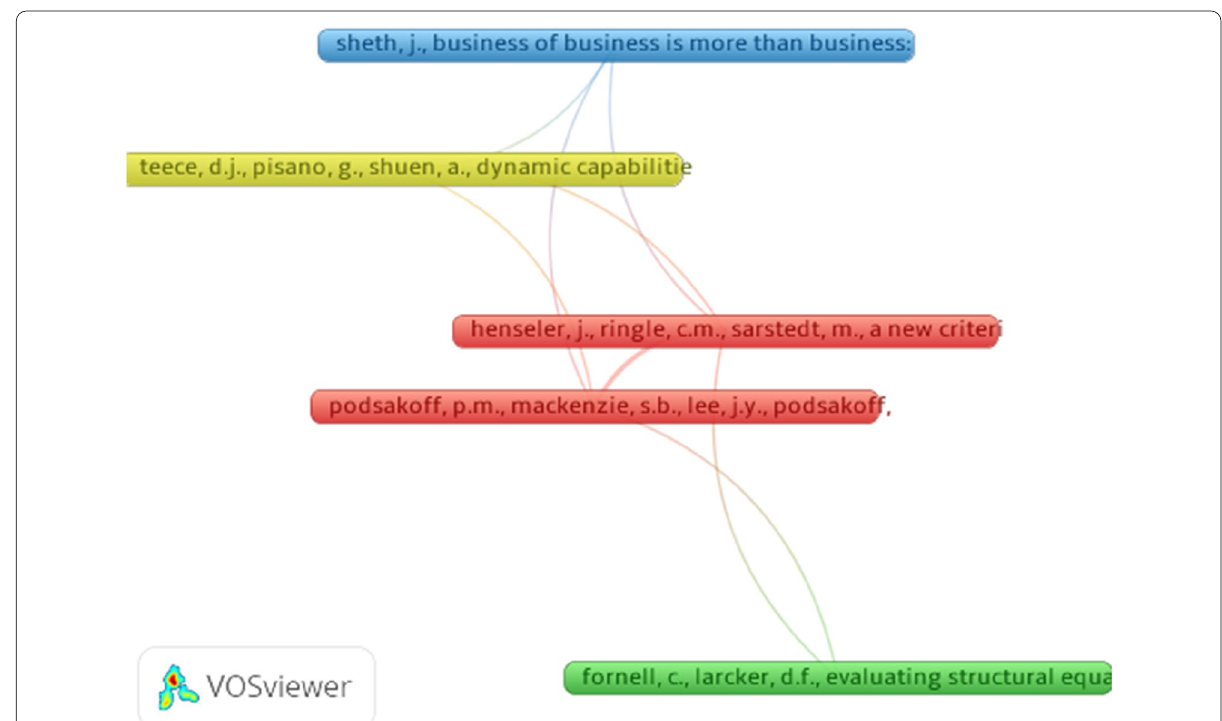
Fig. 3 Network visualization of the largest connected sets of cited